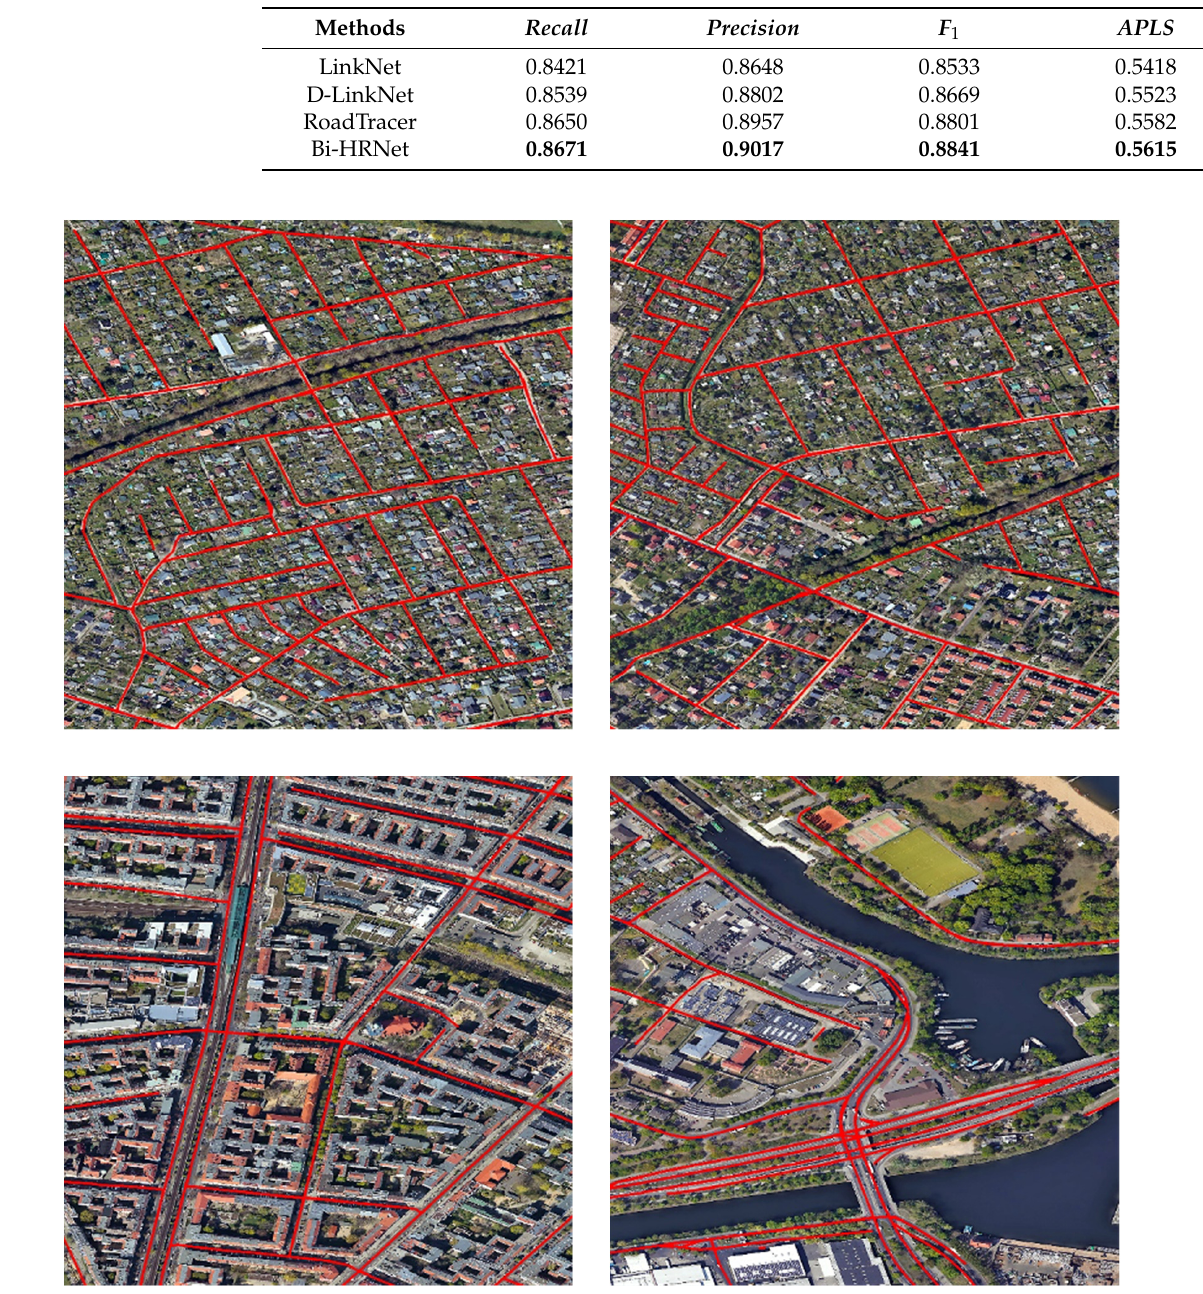
Figure 12. Visualization results of the proposed Bi-HRNet on the constructed Google dataset.